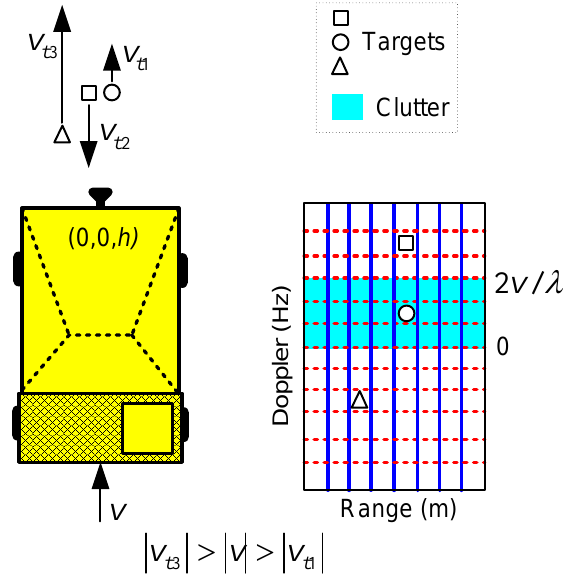
Figure 4. Dependencies of target and dumper velocities in the clutter